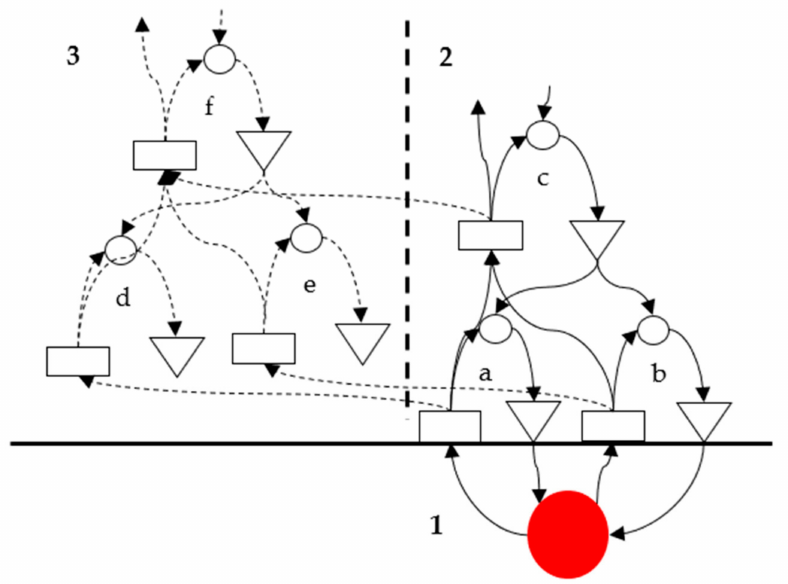
Figure 4. A simplified outline of the functional place of consciousness parallel to (or in the side of) the perceptual control system. Only the basic idea is given here, using only minimal three-unit samples of both systems. 1. In the environment is an object, a “red-ball-being” which affects two input functions of an organism. 2. In the perceptual control system, the control unit a perceives (and possibly controls) a reddish color perception and b perceives a spherical form perception. The unit c combines these perceptions. If the organism happens to want to perceive a red ball, then c sends positive reference signals to a and b . 3. In the logical control system, the unit d recognizes the category of redness, and the unit e the category of sphericalness, and the unit f the category of “red balls”. All these recognitions evoke a certain own kind of feeling in the organism. The logical system can be much more flexible than the perceptual system, because it is not tied in the interaction with the environment and so it can easily produce new combinations of categories. The feedback effects from logical system to perceptual control systems are not drawn, because they probably affect mainly via still one more different system—namely, the reorganization system. This reorganization system just accelerates the continuous changes in the connections and functions of the control